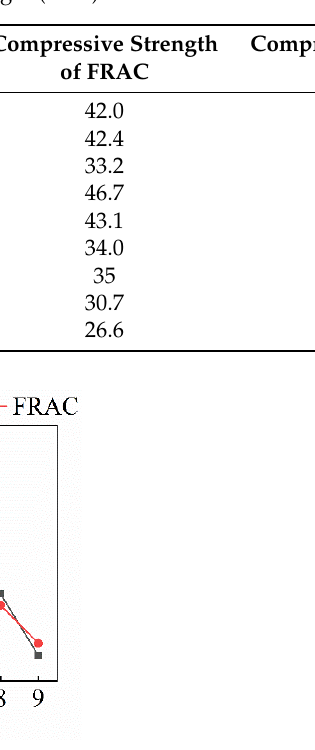
Table 8. Ratio of compressive strength (MPa) between FRAC and mortar.